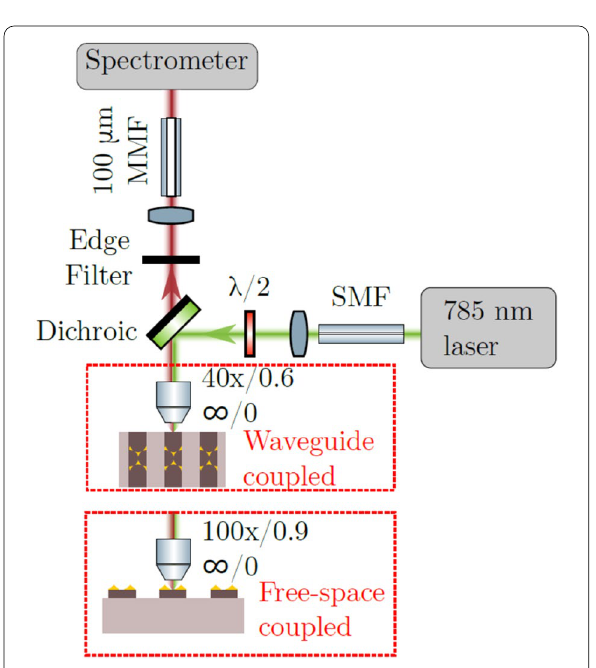
Fig. 8 Schematic of the confocal microscope used for collecting Stokes scattered light from both waveguide- and free-space coupled nanotriangles. (Reprinted with permission from Ref.